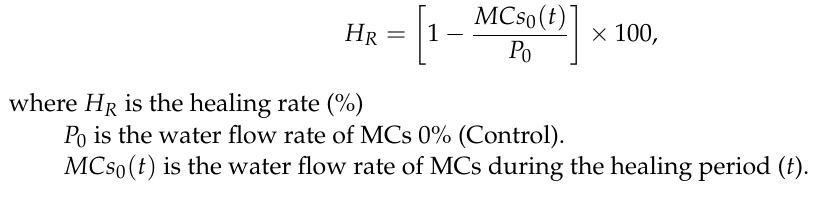
Figure 9. Crack induction and control process: ( a ) crack induction; ( b ) crack control.